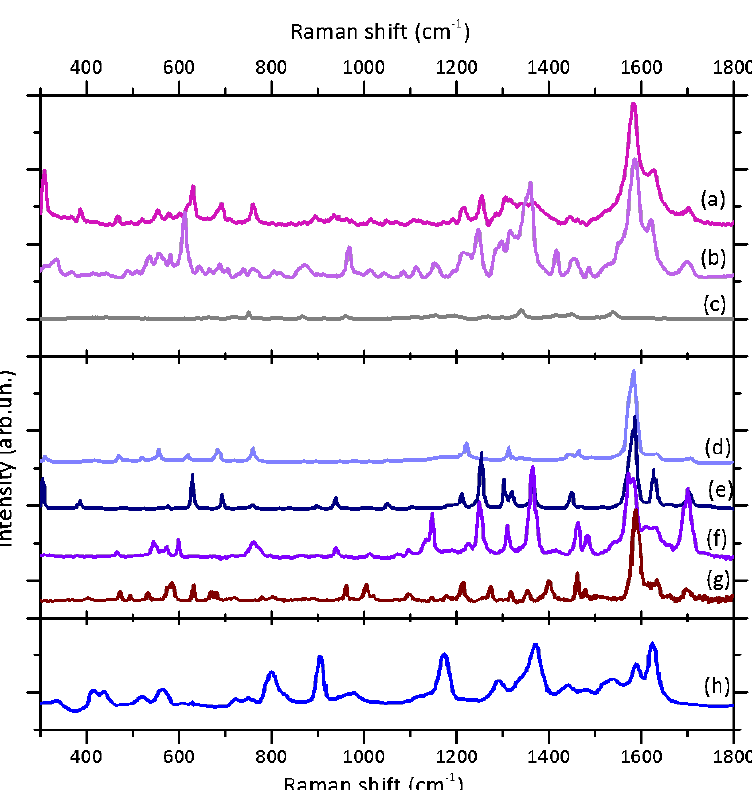
Figure 3. Raman and SERS spectra: results and literature references. Top panel: ( a ) the Raman spectrum acquired on the colored area of the archeological sample and ( b ) the SERS spectrum of the DMF extract from the sample; ( c ) the SERS spectrum of DMF is displayed for reference. Central panel: ( d ) Raman reference spectra of 6-monobromoindigotin (ref. [36], excitation laser line: 785 nm); ( e ) 6,6’-dibromoindigotin (ref. [35], excitation laser line: 633 nm); ( f ) indigotin (ref. [35], excitation laser line: 633 nm); ( g ) indirubin (ref. [40], excitation laser line: 532 nm). Bottom panel: ( h ) the SERS reference spectrum of the DMF extract of indigo acquired using the Lee–Meisel Ag colloid as a SERS substrate [39]. Table 1. Comparison of the main peaks in the Raman spectrum of the sample with the literature ones for indigotin (IND, [35]), indirubin (INR, [40]), 6-bromoindigotin (MBI, [36]) and 6,6’-dibromoindigotin (DBI, [35]) together with their relative tentative assignations based on the literature. Assignation